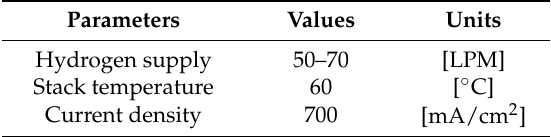
Table 2. Characteristics experimental conditions of fuel